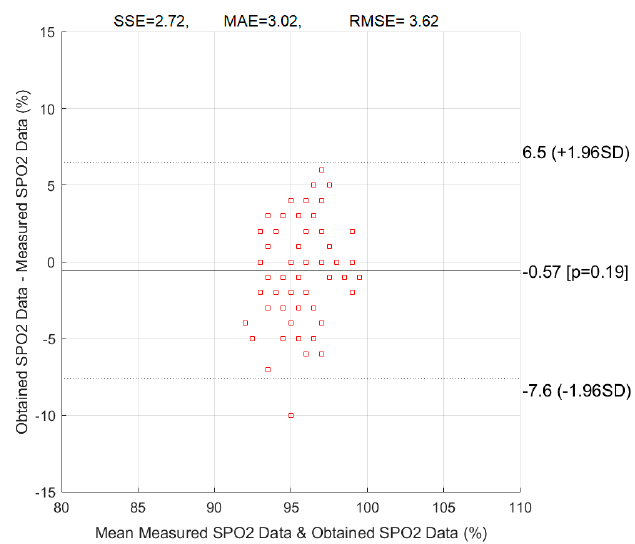
Figure 12. The Bland–Altman and error ratios between the obtained SpO2 and the measured SpO2.